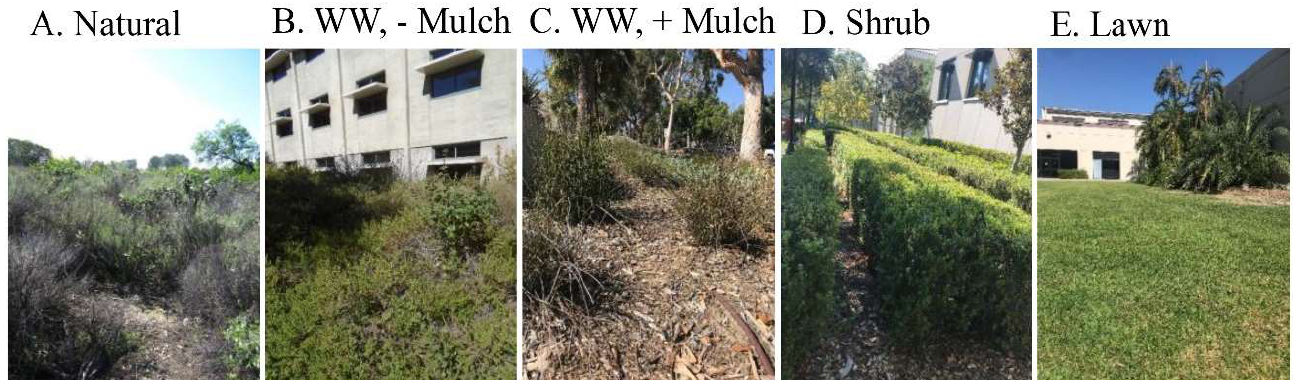
Figure 2. Pictures of the five landcover types at Pomona College in Claremont CA: ( A ) natural areas that have no water subsidies, but may include native sage scrub or a combination of native and non-native plants; ( B ) waterwise (WW) areas without added mulch. These habitats varied significantly among campuses, but were similar in that they were landscapes with water-tolerant plants to reduce water subsidies; ( C ) waterwise areas with mulch; ( D ) shrub areas with hedges and other, mostly non-native shrubs, are featured; ( E ) lawns. For a description of site characteristics for each habitat across the seven colleges, see Supplemental Table S1.